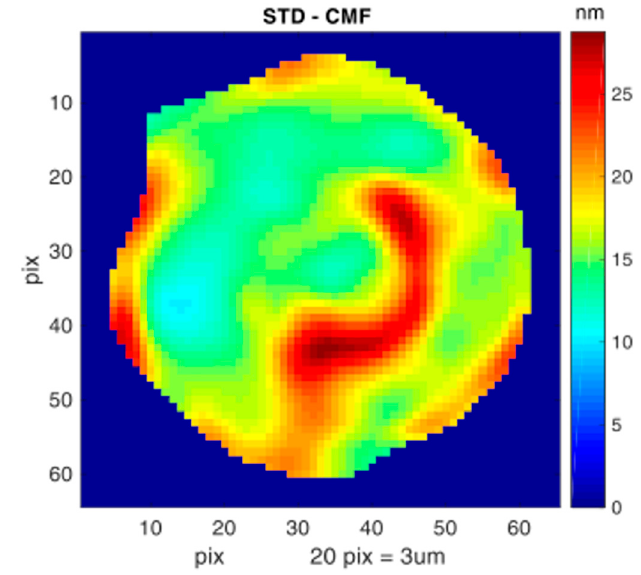
Figure 7. STD_pix—the standard deviation distribution over the cell area.